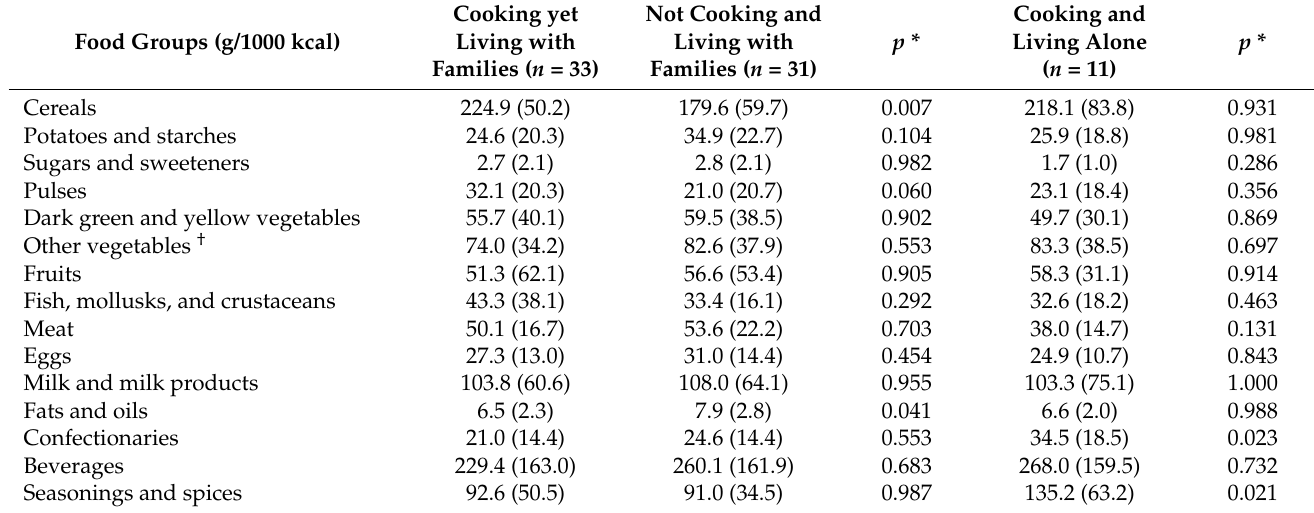
Table 4. Association of cooking with food group intake among female university students ( n =